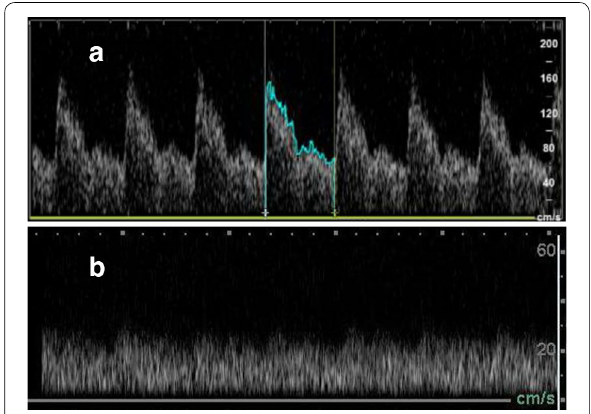
Fig. 7 Disadvantage to transcranial Doppler when interpreting MCA flows for patient with non-pulsatile flow states (i.e., V–A ECMO, LVAD). a Normal pulsatile flow: systolic upstroke with normal step-down of diastolic flow. b Non-pulsatile flow: Loss of sharp systolic peak flows, with overall lowering of means flows—which would make interpreta- tion of pulsatility index for ICP as well as mean flows for